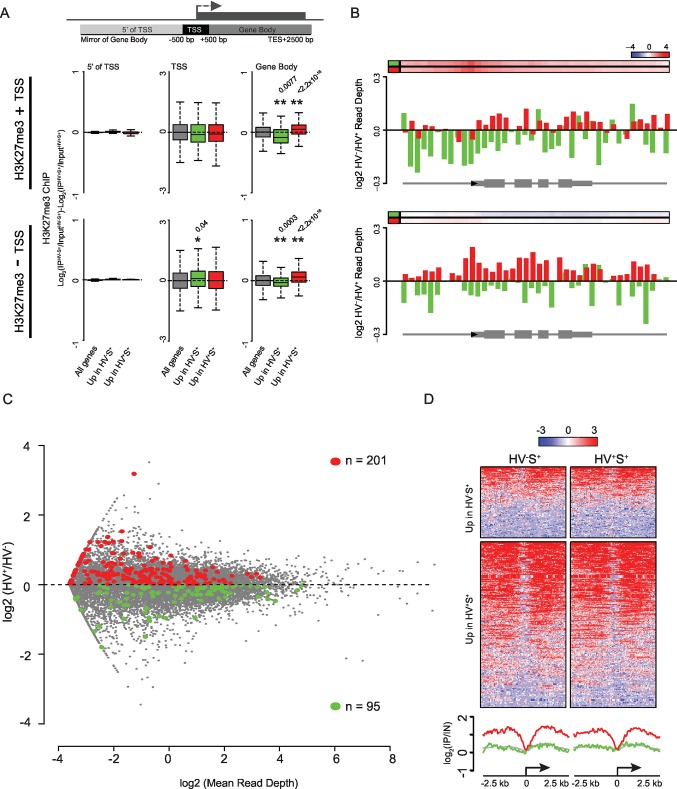
Dynamic changes in gene-body H3K27me3 levels contrasts with a specific enrichment of H3K27me3 at the promoters of PrEn-primed genes.(A) Schematic representation of the stratification used to bin H3K27me3 signal with respect to genes (upper panel). Boxplots showing the log2 ratios of H3K27me3 ChIP-seq signal between the two primed ESC populations for genes with or without an H3K27me3 ‘peak’ at their TSS (middle and lower panels respectively; presented as in Figure 1G). Refseq genes were scored as H3K27me3 +ve if a ‘peak’ was found within 100 bp of the annotated TSS. Two-sample permutation tests (oneway test) were used to compare the H3K27me3 ChIP-seq signal at priming vs all genes. Significant p values are indicated* and their values shown above the plot. (B) H3K27me3 ratios (log2(IPHV-S+/InputHV-S+)-log2(IPHV+S+/InputHV+S+)) between the HV-S+ and HV+S+ populations presented as for Figure 1F. Barplots are presented for priming genes sub-divided into those with or without an associated ‘peak’ of H3K27me3 at their TSS (upper and lower panels respectively; association scored as for (A). (C) MA plot comparing nascent RNA levels (measured by GRO-seq) between HV-S+ and HV+S+ cell populations. Genes found to show a consistent differential RNA signal in both steady-state and GRO-seq datasets are highlighted in green and red (upregulated in HV-S+ and HV+S+ respectively; numbers of genes are indicated within the plot). (D) TSS (± 2.5 kb) heatmaps and summary plots depicting H3K27me3 signal (log2(IP/Input)) for genes with differential steady-state and nascent RNA levels (selection based on panel C) between the HV-S+ and HV+S+ ESC populations.